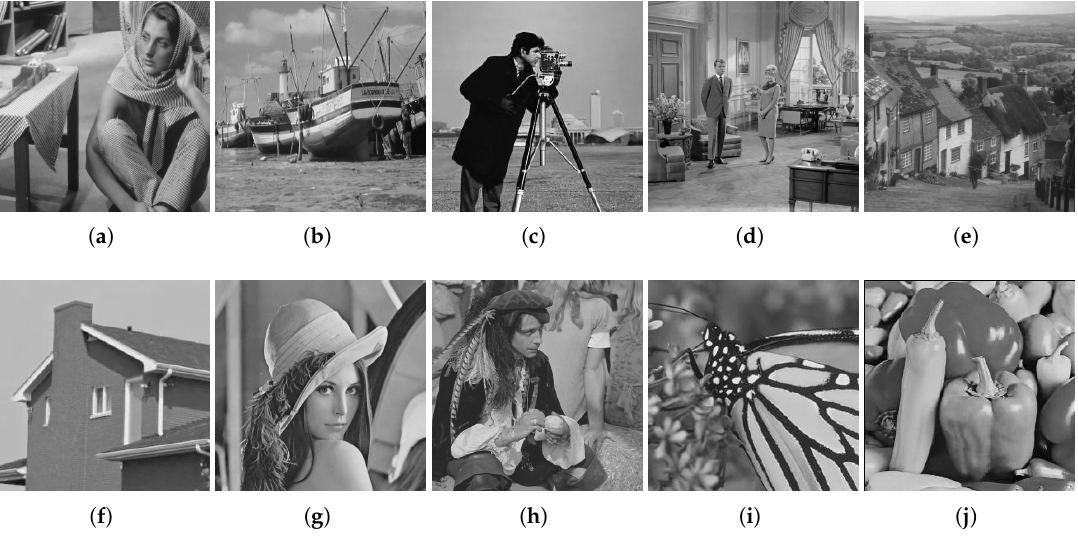
Figure 4. Ten commonly used testing images. ( a ) Barbara. ( b ) Boat. ( c ) Cameraman. ( d ) Couple.